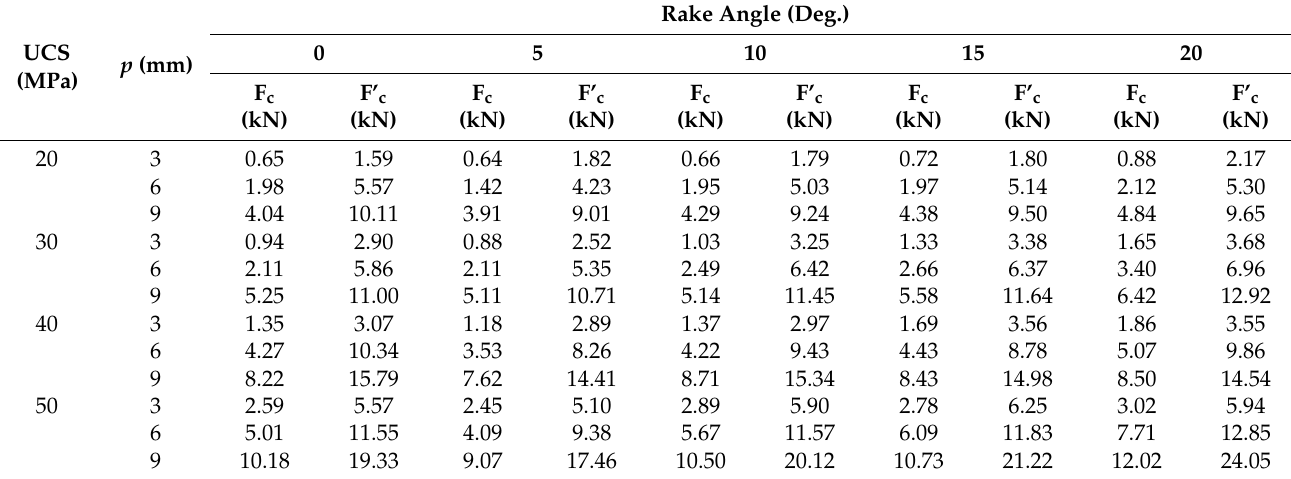
Figure 13. Friction surface of the cutting tool after the cutting test.